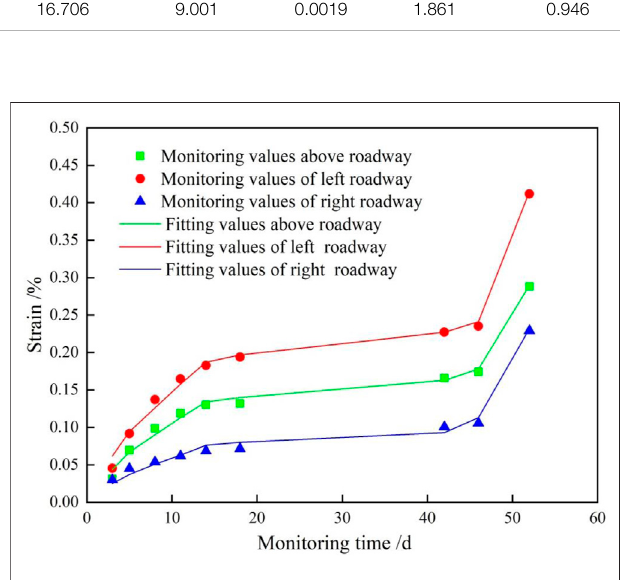
FIGURE 7 | Relationship between numerical monitoring data and theoretical analysis in the damp